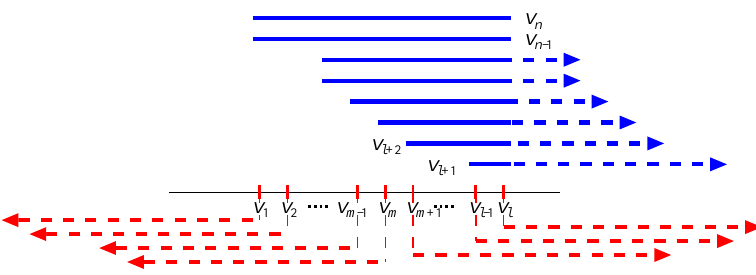
Figure 2. Construction of a minimum